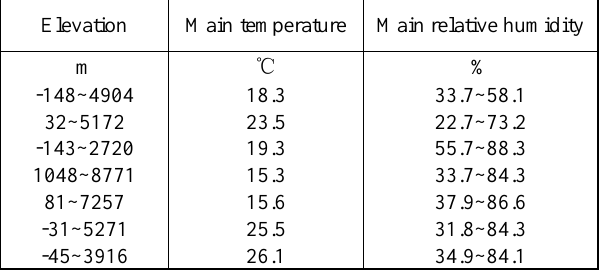
Table 1. Eco-geographical regionalization result